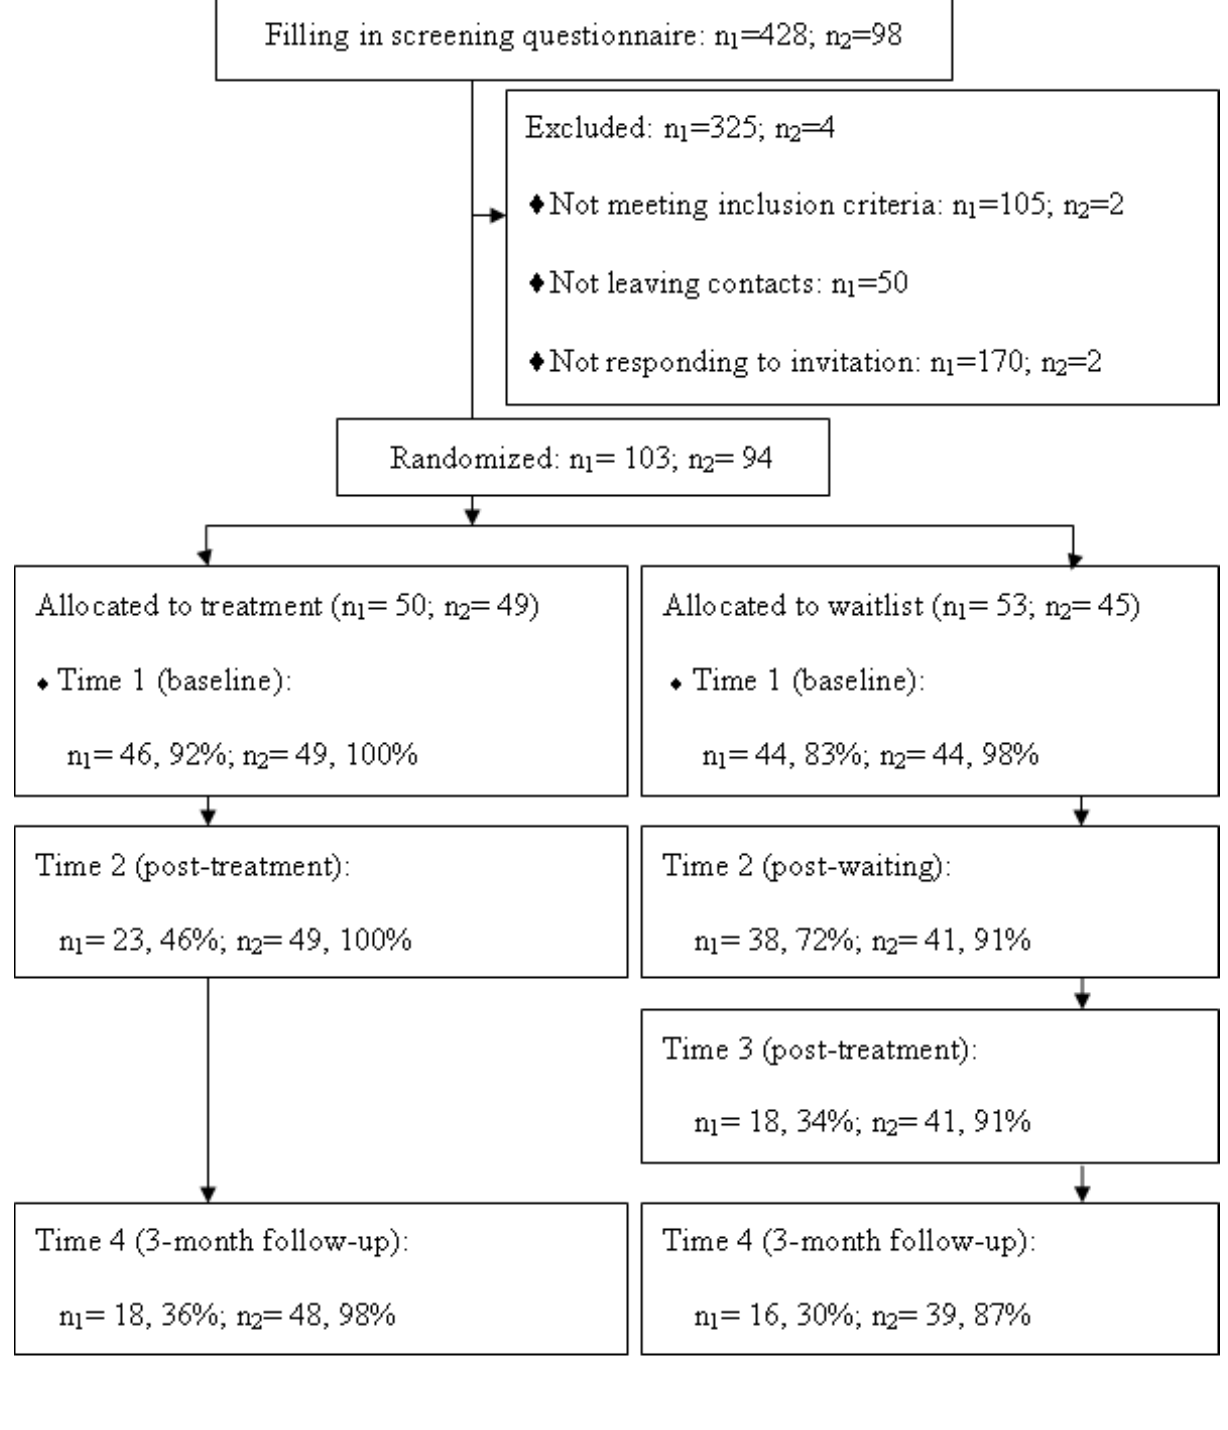
Figure 2. Participant flow in this study. n 1 =number of participants in the urban sample; n 2 =number of participants in the rural